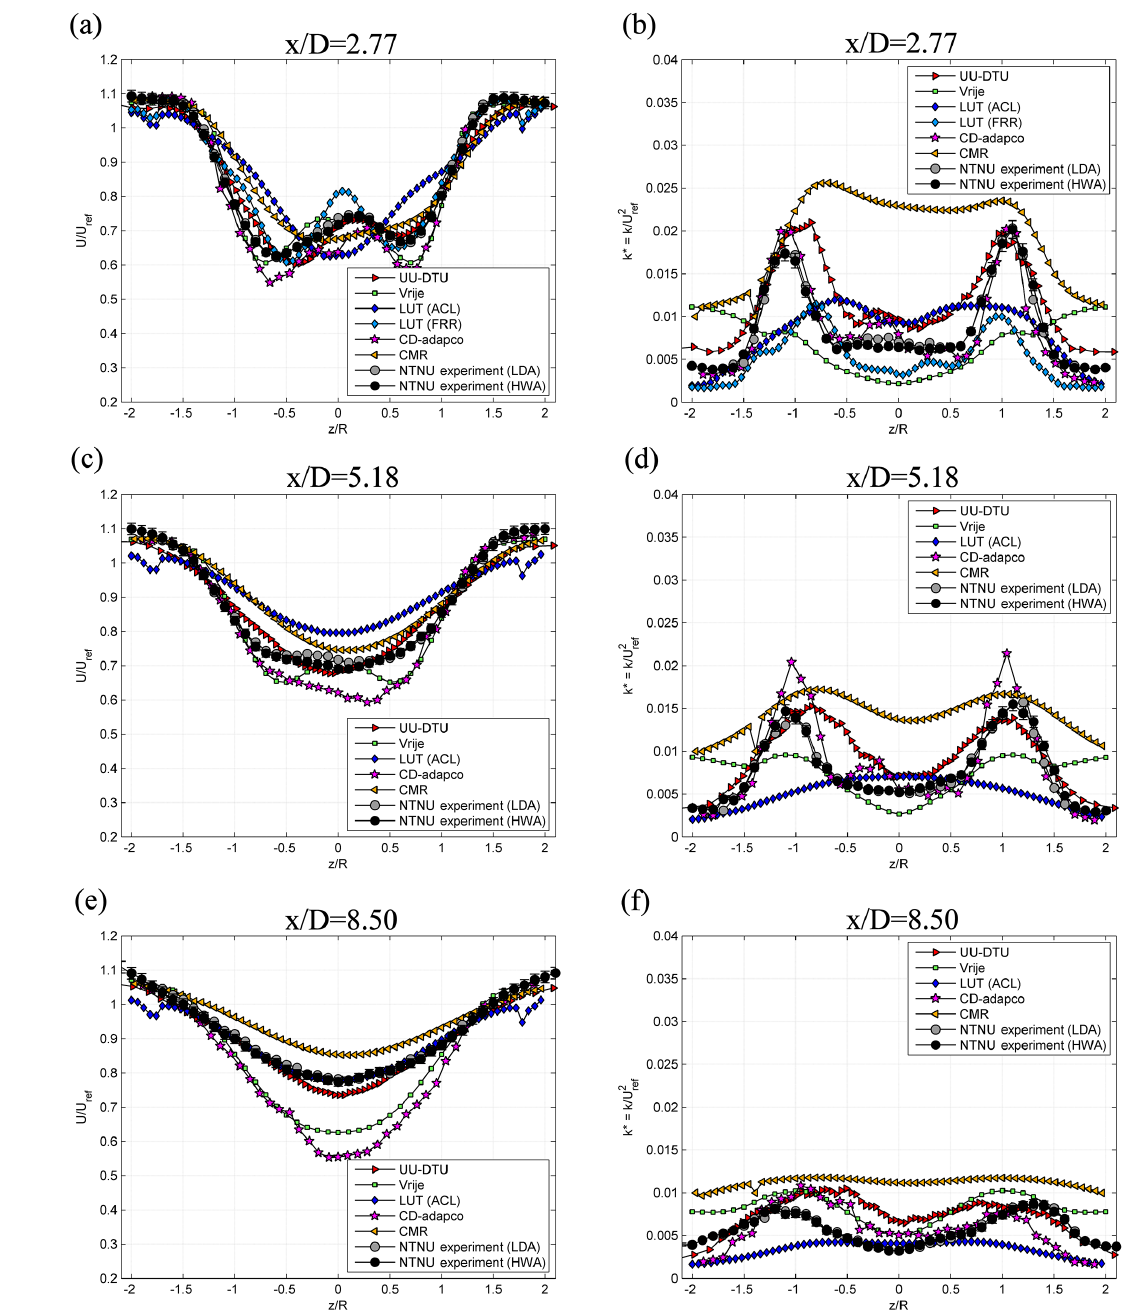
(b, d, f) in the wake x/D = 2.77 (a, b) , ref